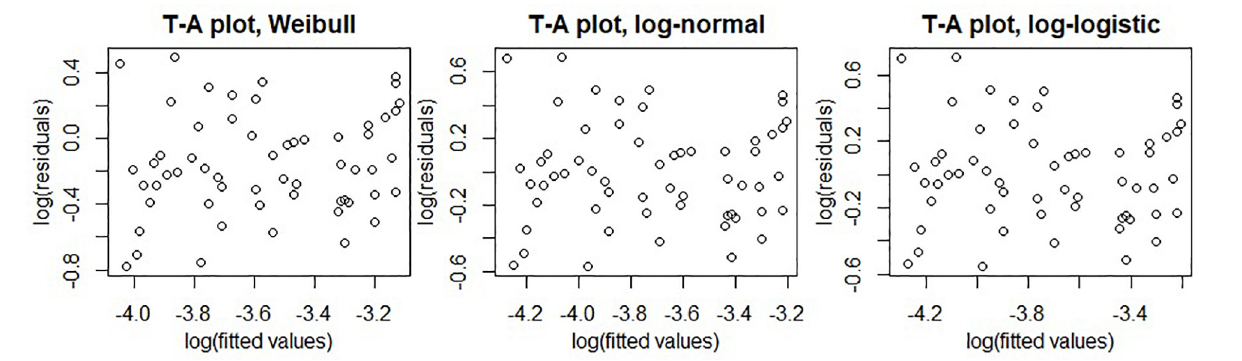
FIGURE B1 | Tukey-Anscombe plots of residuals versus fitted values for fitted Weibull (left) , log-logistic (middle) , and log-normal (right) survival models.